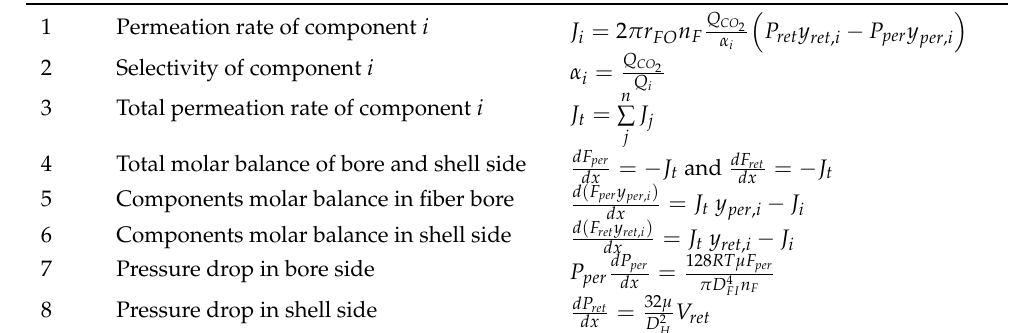
Table 2. Mathematical equations for modeling membrane